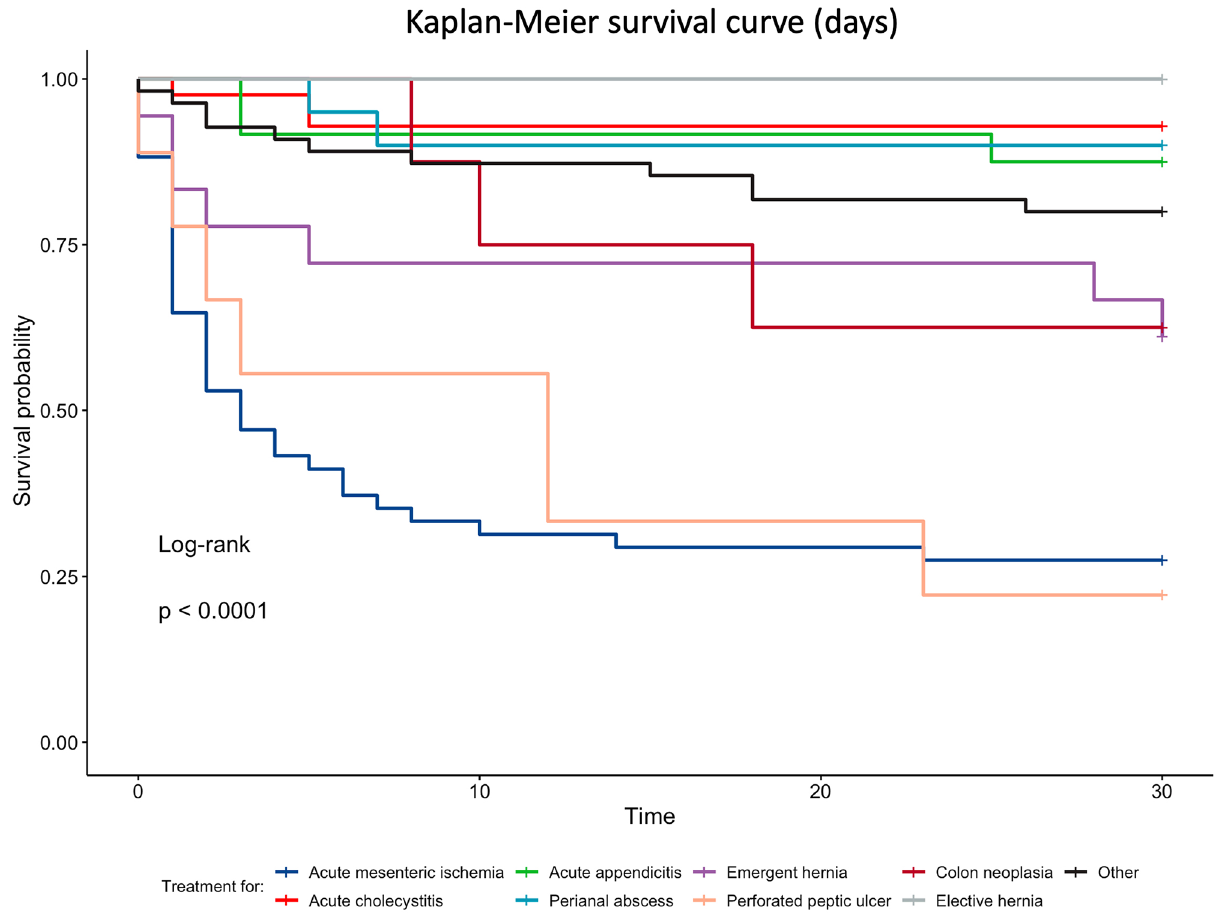
Figure 2. 30 day survival curve in patients with the most common diagnoses.